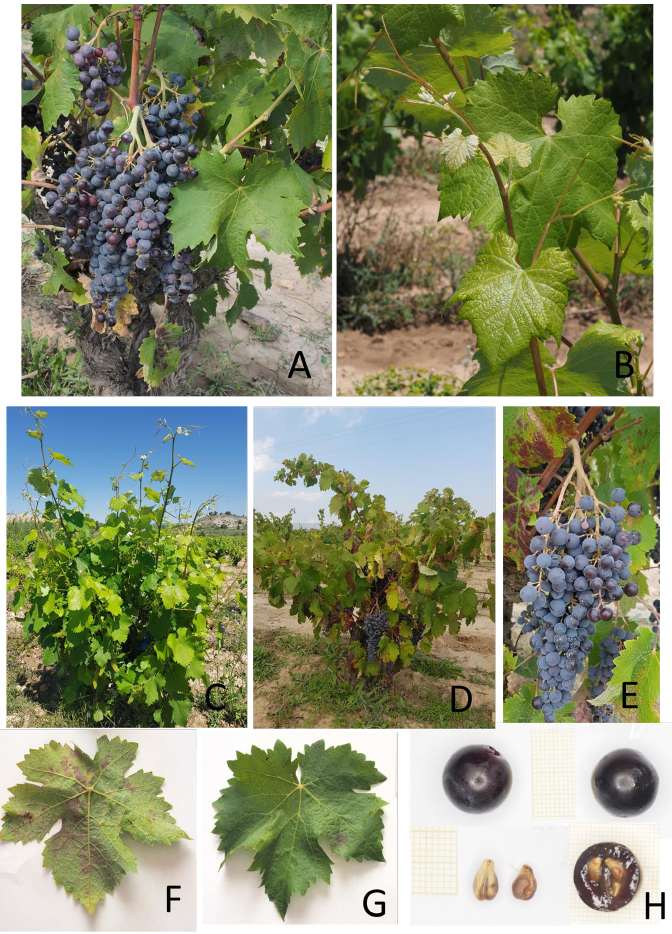
Figure 1. Images from Arcos grapevine variety: conical bunches ( A , E ); tip and young leaves ( B ); vine growth ( C , D ); mature leaves ( F , G ); blue-black globose berries ( H ); seeds ( G ).